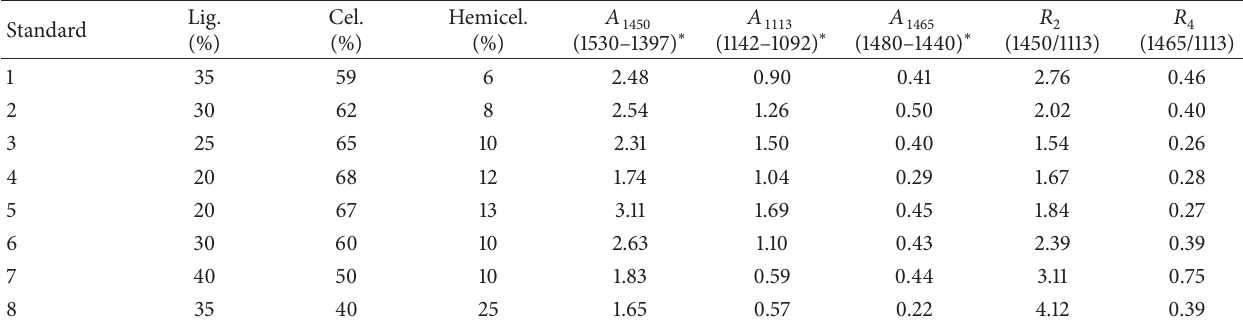
Table 1: Composition of ash-corrected standard ternary mixtures and their infrared data.